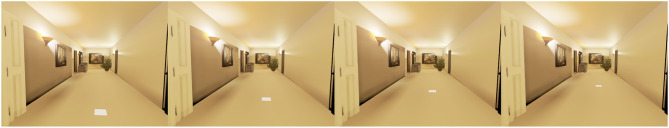
A forward-facing view of the four more distant targets in one of the three hallways. To see the nearest target, it would be necessary to look down slightly.